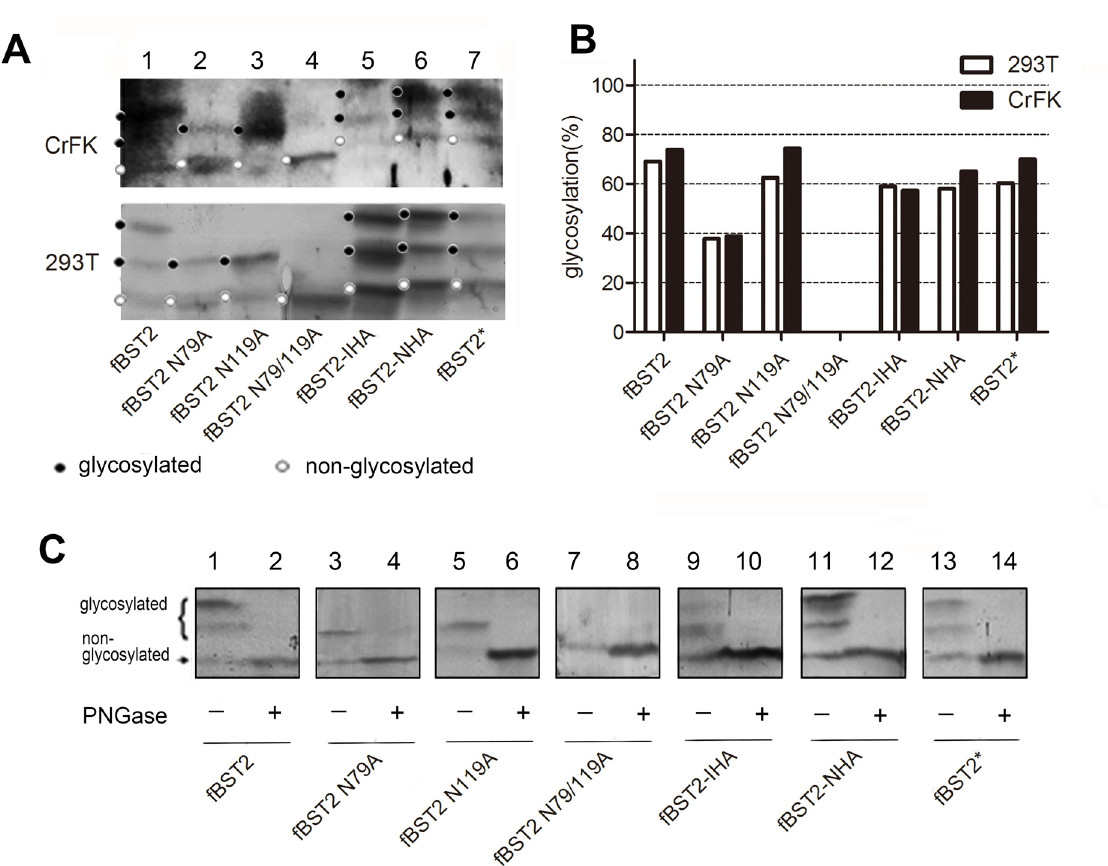
Fig 3. Detection of BST2 proteins and glycosylation analysis. (A) SDS-PAGE analysis of BST2 mutants under denaturing conditions. 293T cells and CrFk cells were transfected with 500 ng of fBST2, fBST2 N79A, fBST2 N119A, fBST2 N79/119A, fBST2-IHA, fBST2-NHA and fBST2 * . After 48 h, cells were harvested and analyzed by Western blotting using the anti-BST2 pAb. The major bands corresponding to higher and lower glycosylated BST2 are marked with symbols. (B) Blots of BST2 in A were quantified using Bandscan software. The higher and lower glycosylated BST2 bands are shown in a column diagram, and all three bands of each BST2 were treated as 100%. (C) The fBST2, fBST2 N79A, fBST2 N119A, fBST2 N79/119A, fBST2-IHA, fBST2-NHA and fBST2 * plasmids (each 500 ng) were transfected into 293T cells. Cells were harvested 48 h after transfection and divided into two portions. Cell lysates were incubated in the presence or absence of PNGase F and analyzed by Western blotting using the anti-fBST2 pAb. This experiment was repeated three times, and the most representative data are shown.